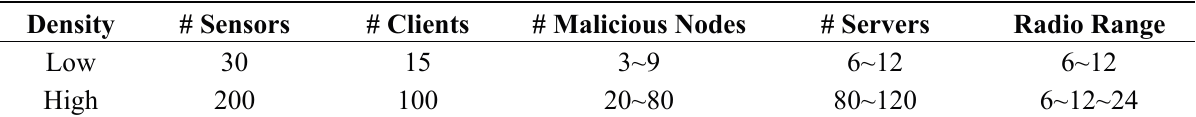
Table 1. Simulation